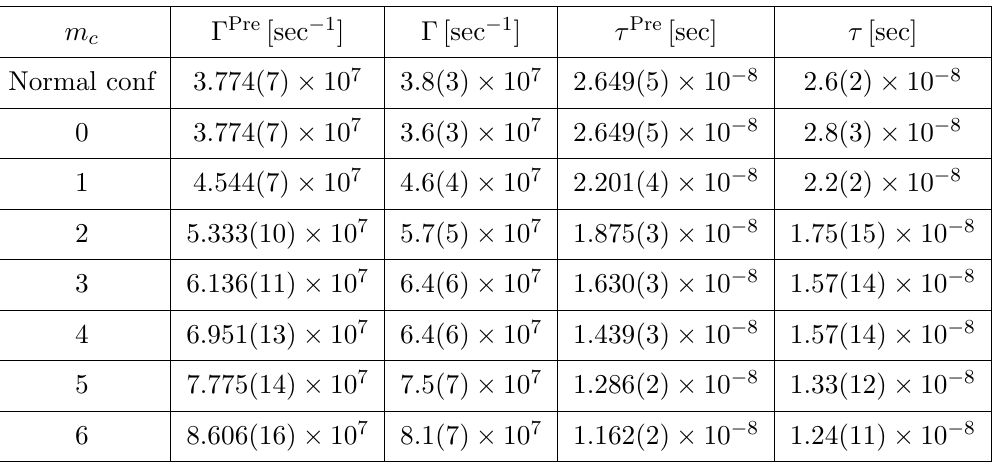
Figure 26 . Comparisons of the decay width (cid:0) (left) and the lifetime (cid:28) (right) of the charged pion with the predictions. The black symbols and lines indicate the predictions and (cid:12)tting results, respectively. The blue and red symbols and lines indicate the numerical results and (cid:12)tting results, respectively.